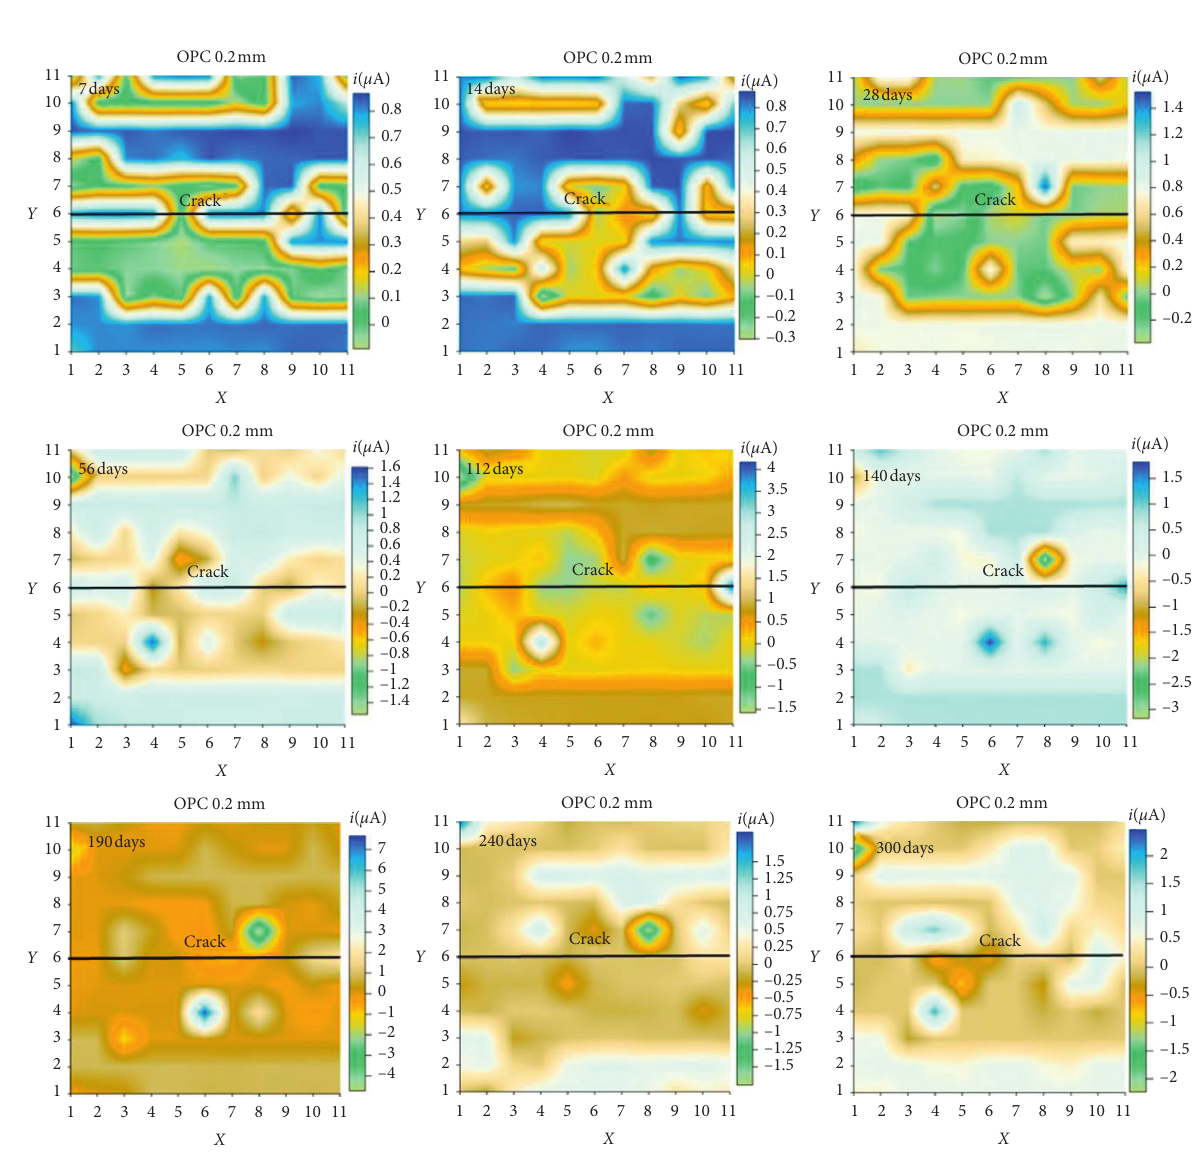
Figure 16: Current distribution of WBE protected by OPC mortar with 0.2mm